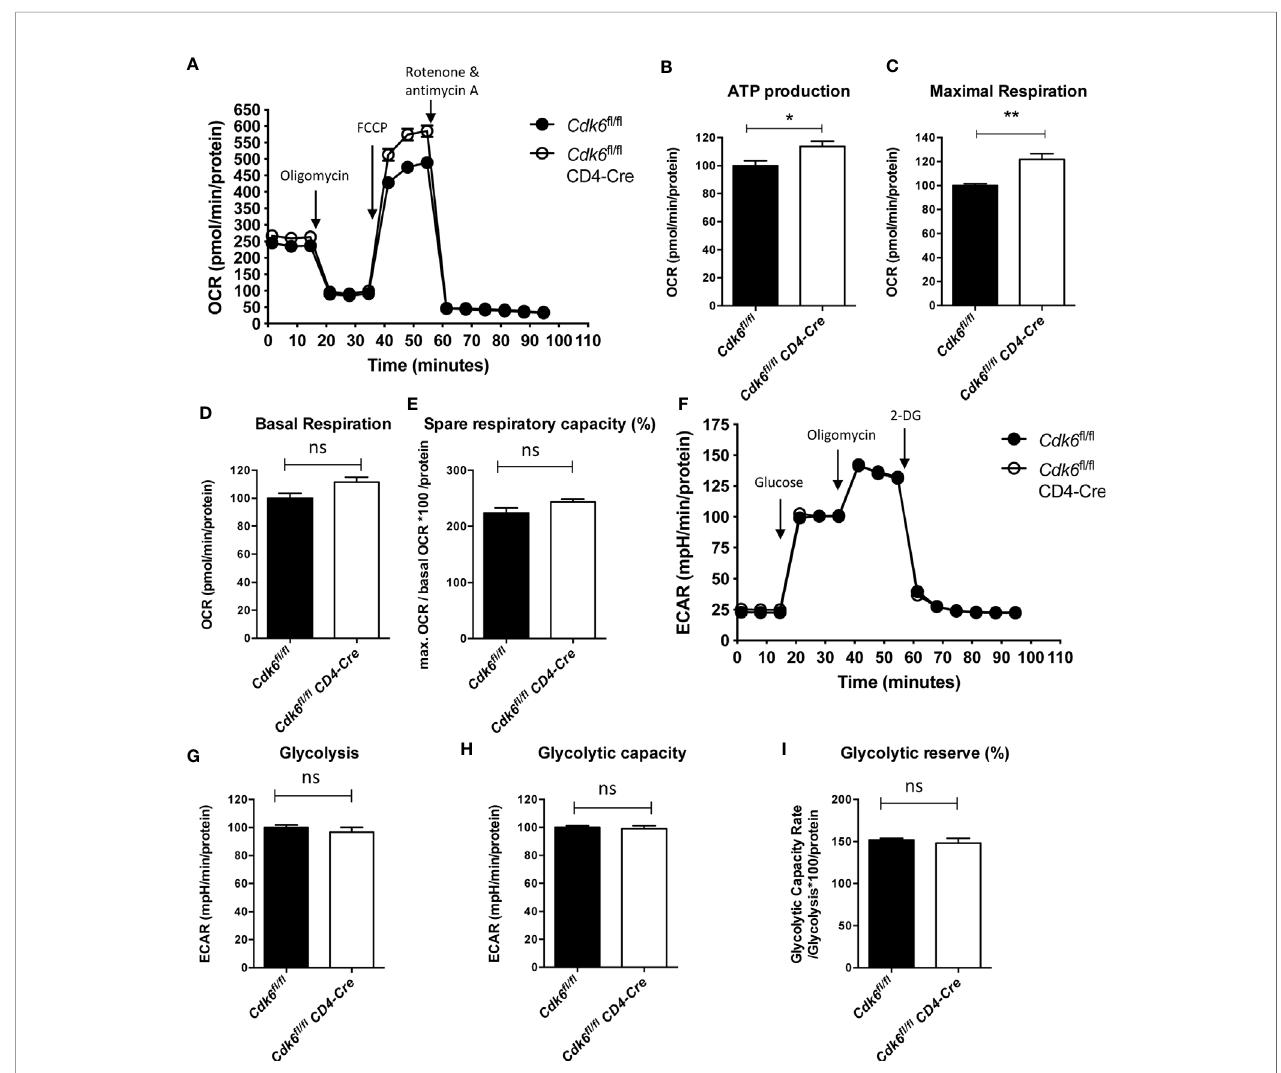
FIGURE 4 | Loss of CDK6 increases mitochondrial respiration of CD8+ T cells in vitro . Naïve CD8+ T cells were isolated from spleens of Cdk6 fl / fl and Cdk6 fl / fl CD4- Cre mice and cultured for 48h on a CD3/ a CD28 coated wells in presence of IL-2. (A – E) Agilent Seahorse XF Cell Mito Stress Test was performed with cultured CD8+ T cells. (A) Oxygen consumption rate (OCR) curves are shown. Injections of oligomycin (Injection 1), FCCP (Injection 2) and rotenone and antimycin A (Injection 3) are indicated by arrows. ATP production (B) , maximal respiration (C) , basal respiration (D) and spare respiratory capacity (as %) (E) were calculated for Cdk6 fl / fl and Cdk6 fl / fl CD4-Cre CD8+ T cells (n=4). (F – I) Agilent Seahorse XF Glycolysis Stress Test was performed with cultured CD8+ T cells. (F) Extracellular acidi fi cation rate (ECAR) curves are shown. Injections of glucose (Injection 1), oligomycin (Injection 2) and 2-deoxy-glucose (2-DG) (Injection 3) are indicated by arrows. Glycolysis (G) , glycolytic capacity (H) and glycolytic reserve (as %) (I) were calculated for Cdk6 fl / fl and Cdk6 fl / fl CD4-Cre CD8+ T cells (n=4). (B – E, G – I) Bar graphs represent mean ± SEM, pooled from two independent experiments. **p < 0.01, *p < 0.05, unpaired t-test. (A, F) Symbols in curves represent mean ± SEM (n=4 biological replicates per genotype with 8 technical replicates). ns, not signi fi